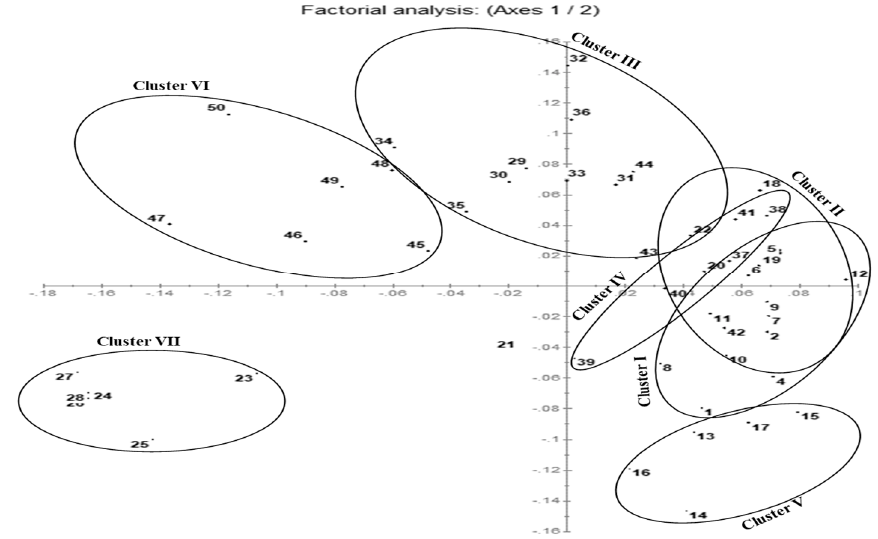
Figure 5. Principal coordinate analysis (PCoA) plot of 50 accessions of C. intybus species based on ISSR marker data: (1–12 = CIN–BD, 13–17 = CIN–BM, 18–22 = CIN–AN, 23–28 = CIN–SR, 29–36 = CIN–GA, 37–44 = CIN–PU and 45–50 = CIN–BU).